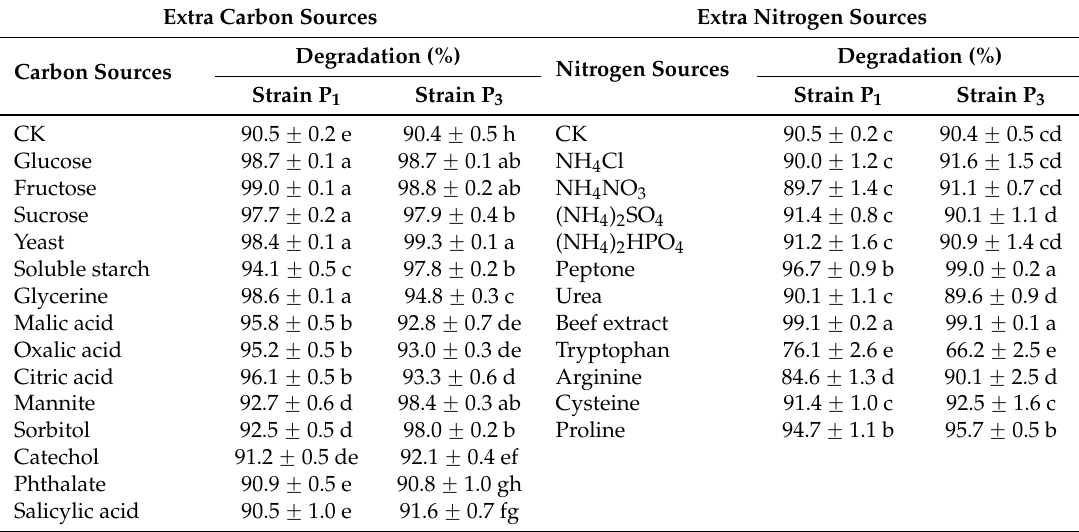
Table 3. Effects of additional carbon and nitrogen nutrients on the degradation of